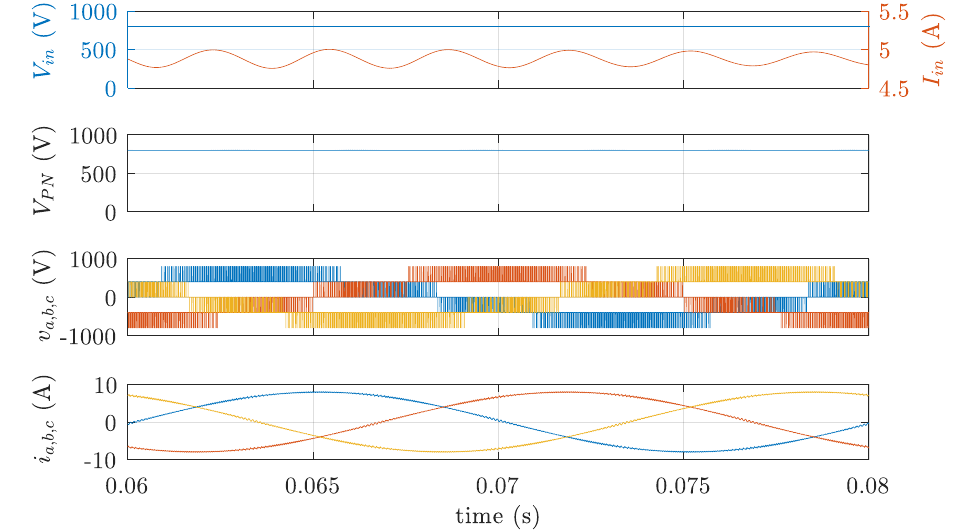
Figure 6. Simulation results for the UST/LST strategy, switching frequency 10 kHz, m = 0.8, and 𝐷 0 = 0 . Top to bottom: input voltage ( 𝑉 𝑖𝑛 ) and input current ( 𝐼 𝑖𝑛 ); DC-link voltage ( 𝑉 𝑃𝑁 ); and line-to-line voltages before filtering ( 𝑣 𝑎𝑏 , 𝑣 𝑏𝑐 , and 𝑣 𝑐𝑎 ) and output currents ( 𝑖 𝑎 , 𝑖 𝑏 , and 𝑖 𝑐 ).